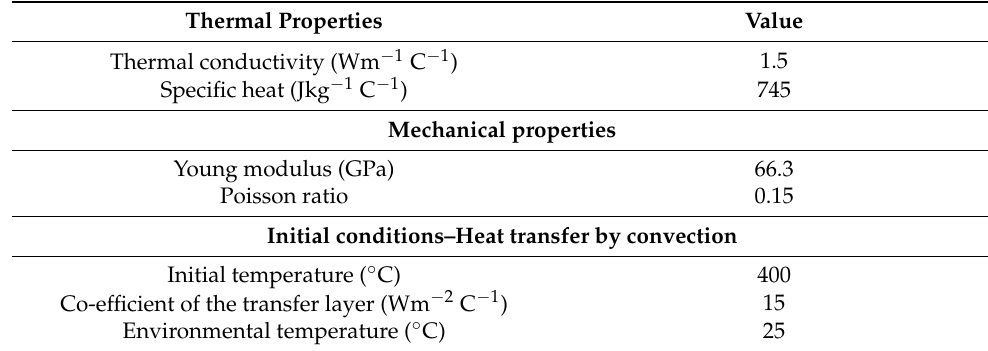
Table 4. Thermal and mechanical properties considered for the SiO 2